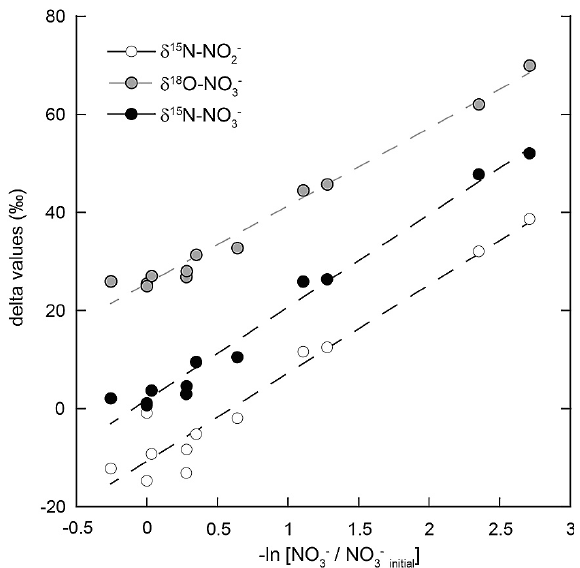
Fig. 4. Rayleigh plots of the change in the N isotopic composition of nitrate ( δ 15 N and δ 18 O) and nitrite ( δ 15 N) as a function of the natural logarithm of the remaining nitrate